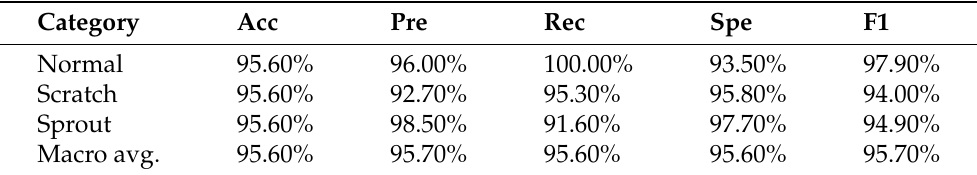
Table 4. Effect of different detection regions on model performance for the OOS test set.